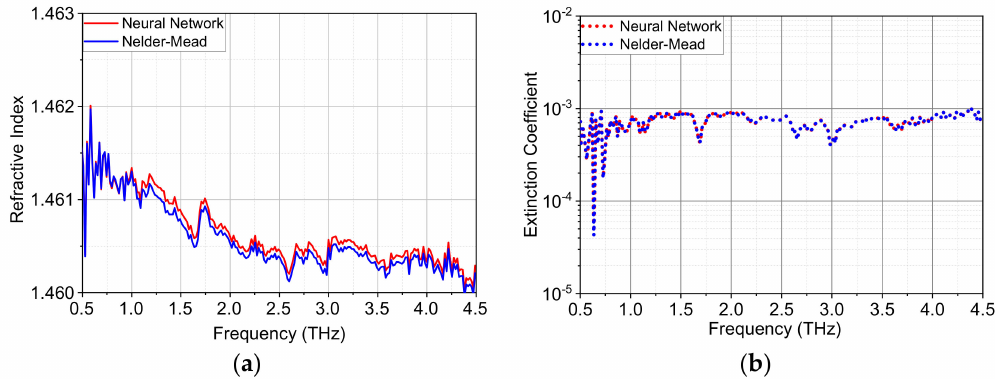
Figure 5. Comparison of extracted optical constants between neural network method and Nelder- Mead algorithm for TPX with a thickness of 3.538 mm: ( a ) refractive index and ( b ) extinction coefficient.